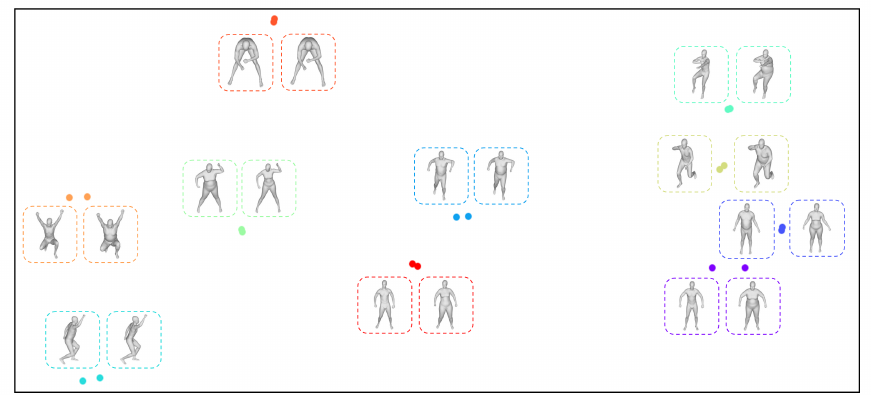
Figure 5. 2D descriptors embedding learned by the Siamese network of poses in the SHREC-RE datasets, where the same colors indicate the same poses.